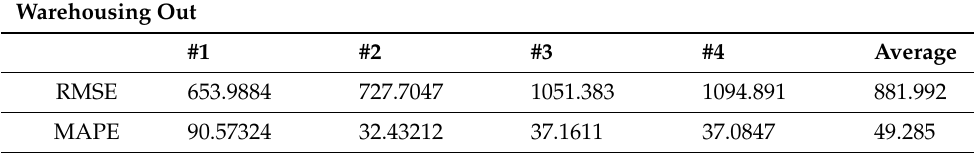
Table 3. Performance of LSTM prediction for warehousing out data. Warehousing